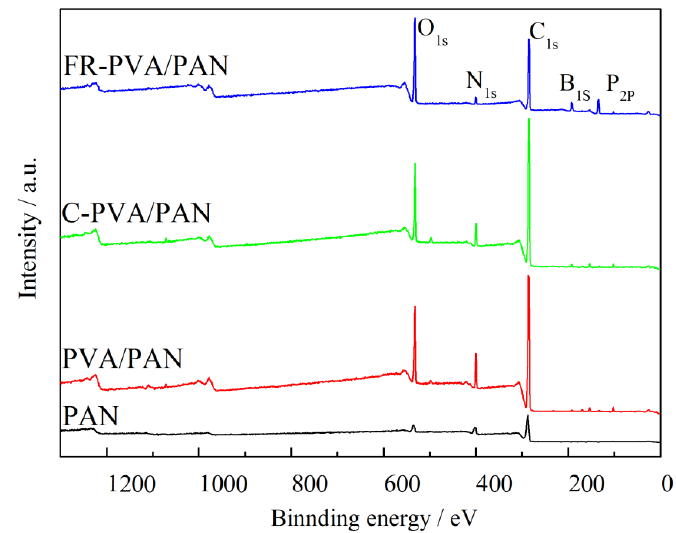
Figure 2. XPS spectra of PAN, PVA/PAN, C-PVA/PAN, and FR-PVA/PAN fibers.